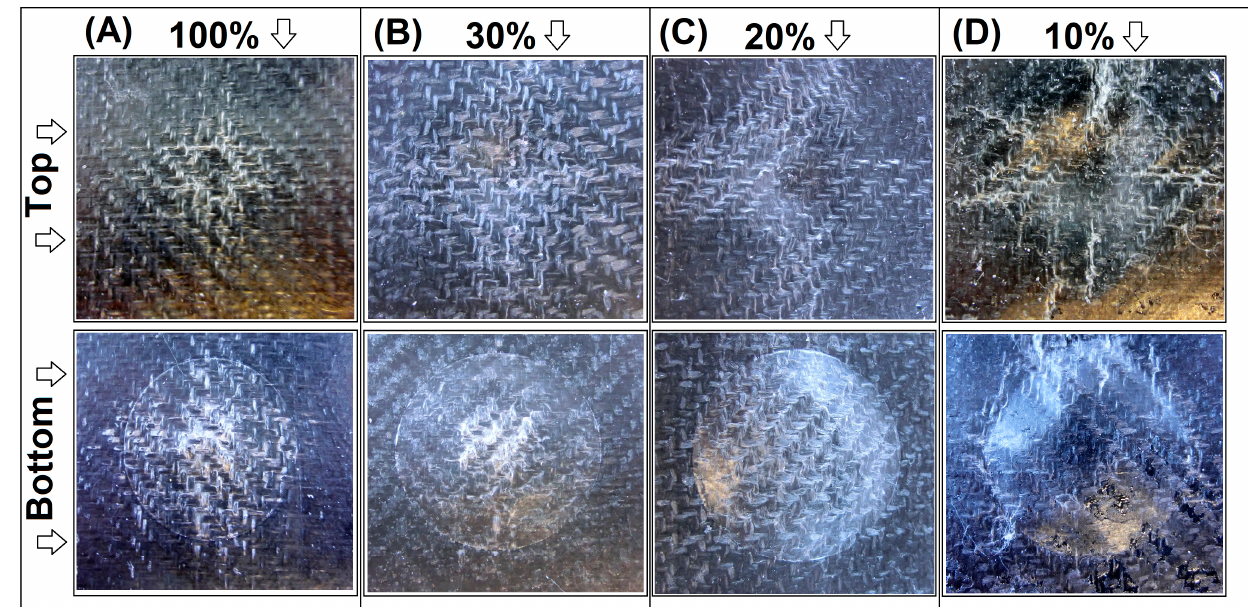
Figure 8. The appearance of the top and bottom surface of the sandwich sample after the drop weight test. Pure GPET samples: ( A ) 100% infill, ( B ) 30% infill, ( C ) 20% infill, and ( D ) 10% infill.